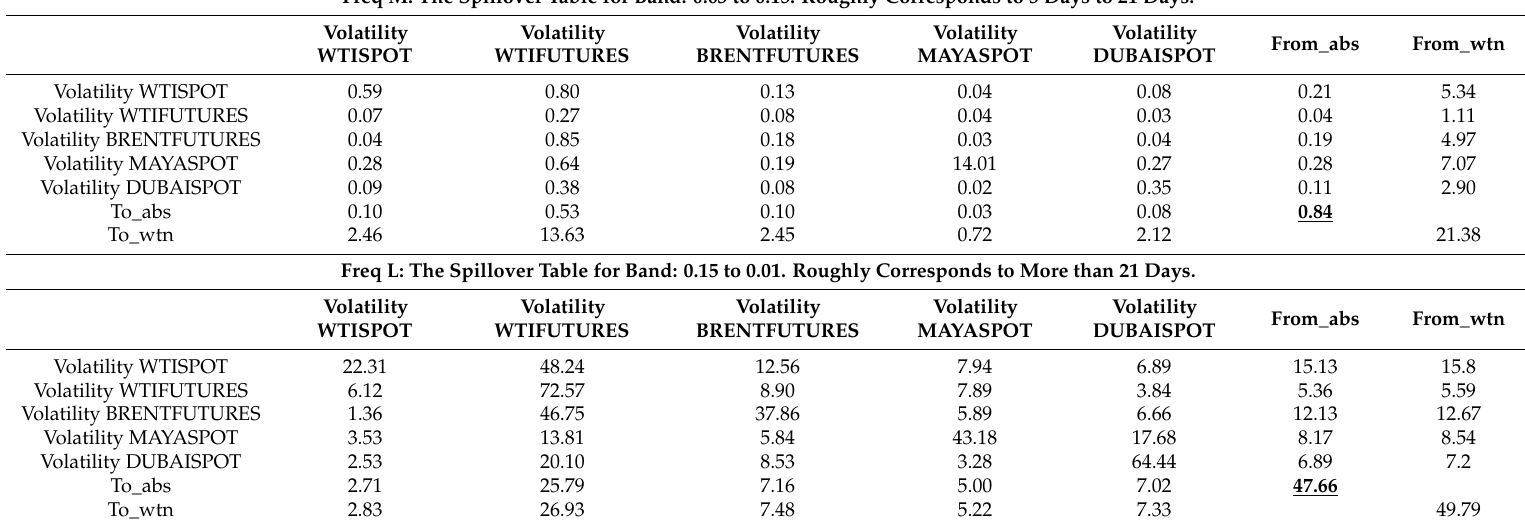
Freq M: The Spillover Table for Band: 0.63 to 0.15. Roughly Corresponds to 5 Days to 21 Days.